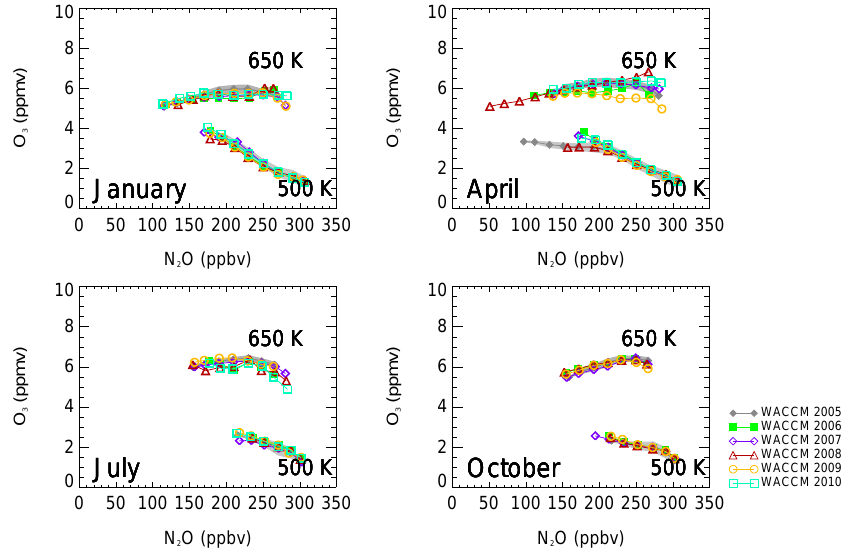
Fig. 6. Same as figure 3 but for SD-WACCM simulations for the years 2005–2010: 2005 (grey diamonds) Fig. 6. Same as Fig. 3, but for SD-WACCM simulations for the years 2005–2010: 2005 (grey diamonds) and 2006 (blue circles), 2007 (green and 2006 (blue circles), 2007 (green squares), 2008 (violet diamonds), 2009 (dark red triangles), 2010 (gold squares), 2008 (violet diamonds), 2009 (dark red triangles), 2010 (gold circles). Note: 2005 is used here as circles). Note: 2005 is used here as reference.